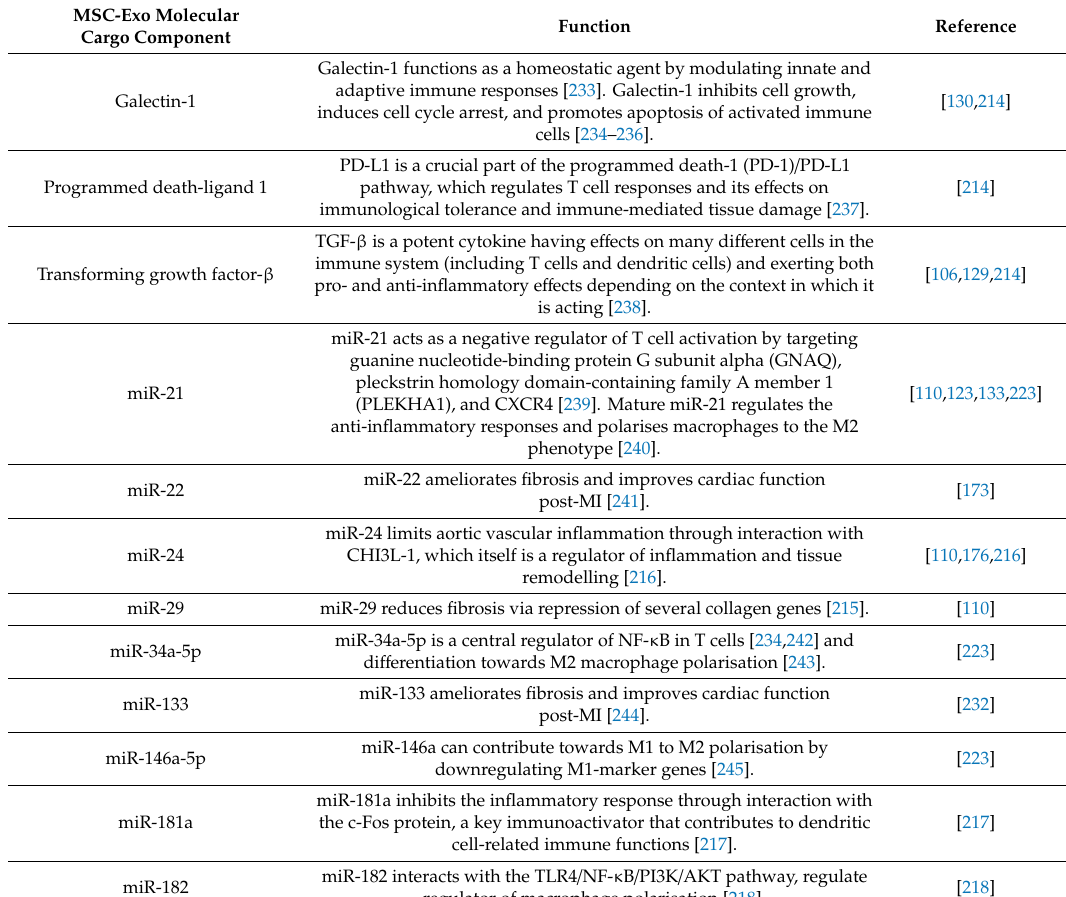
Table 3. List of components of the mesenchymal stem cell-derived exosomes (MSC-Exos) molecular cargo selected for their known potential to regulate the immune